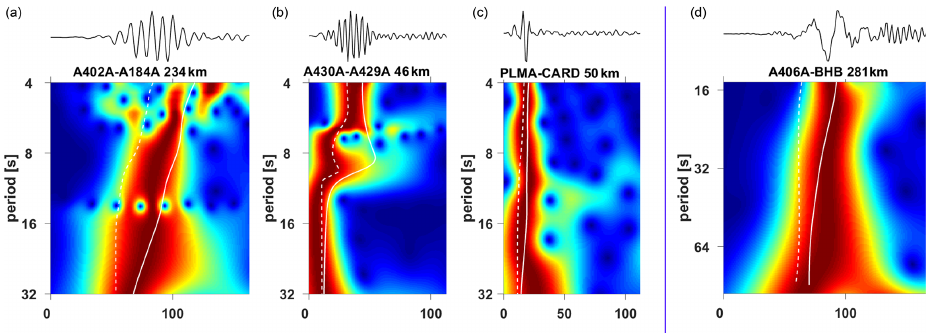
Figure 3. MFT examples for correlations on (a) OBS–land pair, (b) OBS–OBS pair, (c) land–land pair (all ambient noise cross-correlations), and (d) land–land station pair (cross-correlation containing teleseismic event). The solid white line shows the theoretical fundamental mode; the dashed white line shows the theoretical first higher mode. In (a ), (c) , and (d) , the theoretical fundamental mode fits the theoretical velocities. In (b ), the theoretical first higher mode correlates most strongly. Therefore, pair (b) was excluded from the tomography.